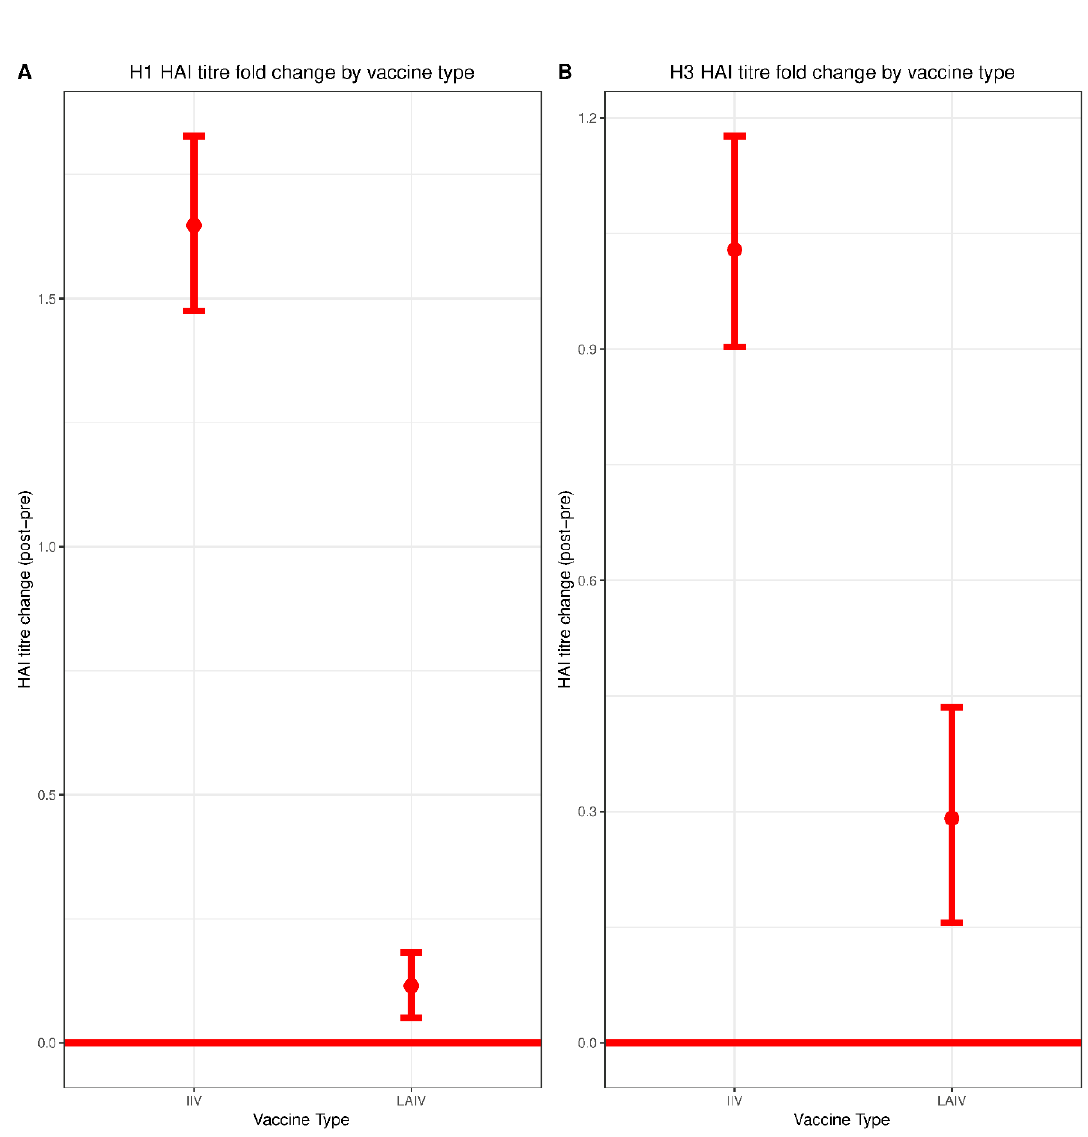
Figure 1. H1N1 and H3N2 pre/post-vaccination hemagglutination inhibition (HAI) titer change by vaccine type. HAI assays were performed against ( A ) Cal/09 H1N1 and ( B ) Tex/50 H3N2 viruses. Log 2 transformed changes in HAI titer from pre-vaccination to post-vaccination were plotted for each vaccine formulation. Live-attenuated influenza vaccines (LAIV), n = 340; inactivated influenza vaccines (IIV), n = 278. Significance of HAI titer change within each vaccine group was evaluated by paired Student t test. Differences between vaccine groups (IIV vs. LAIV) were assessed using Mann–Whitney U Test.